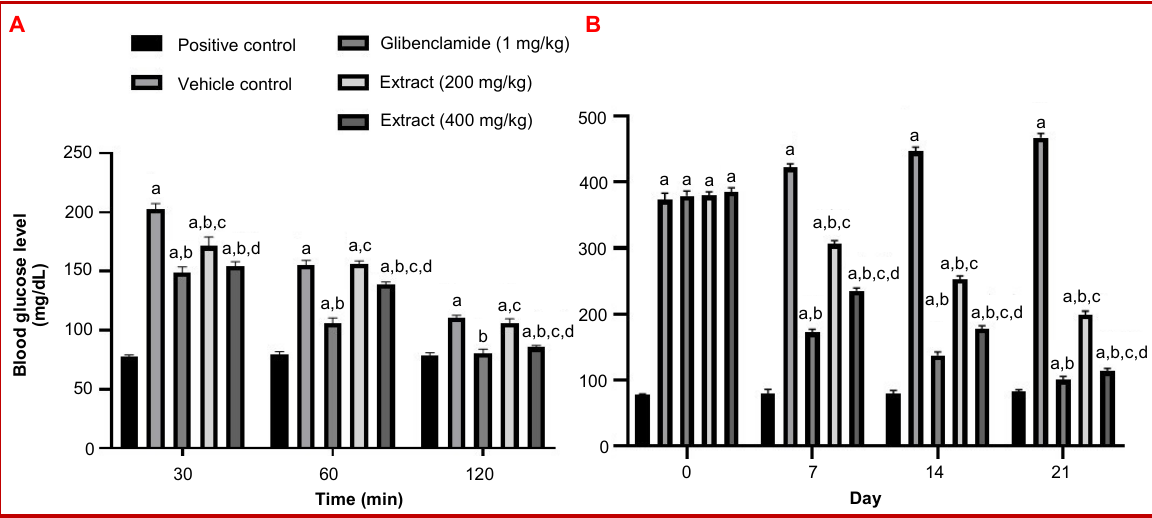
Figure 1: Effect of hydroalcohol extract of A. wallichii on oral glucose tolerance test (A); and anti-diabetic effect in streptozotocin- nicotinamide type-2 diabetic rat (B). Superscript a, b, c, or d denotes p<0.05 when compared with positive control, vehicle control, glibenclamide (1 mg/kg) and extract (200